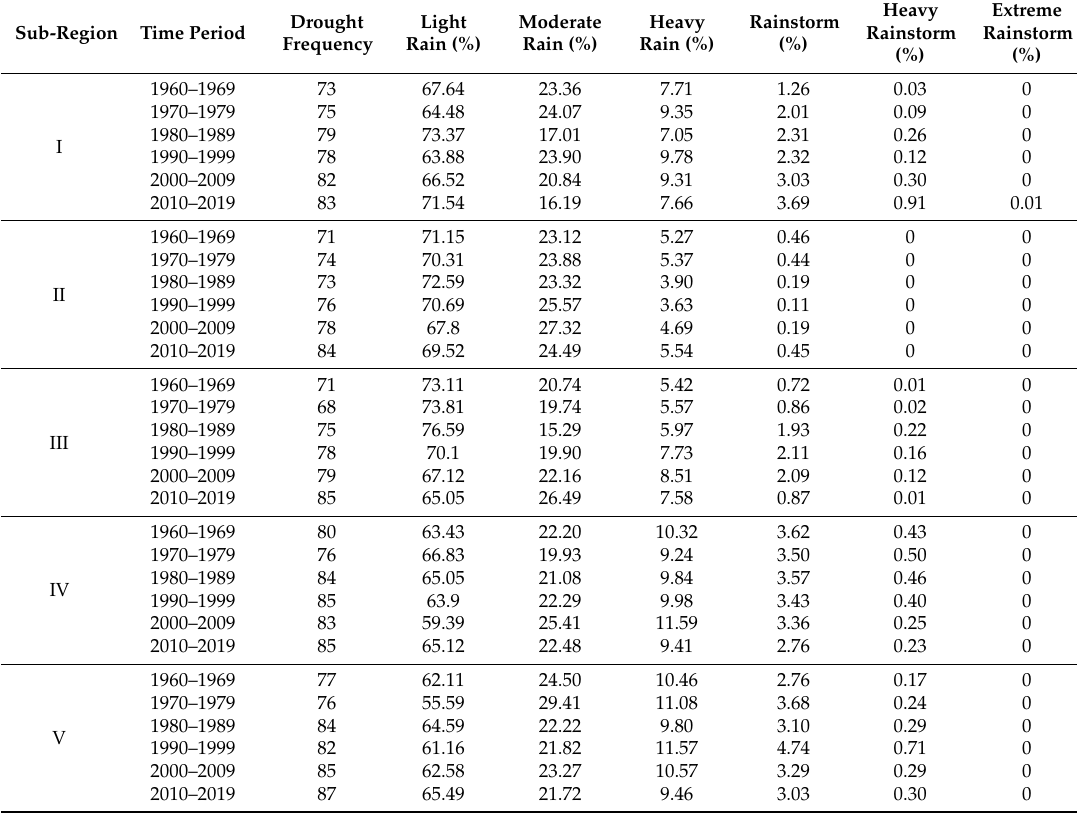
Table 5. Drought frequencies and probability of precipitation intensities in each sub-region. Sub-Region Time Period